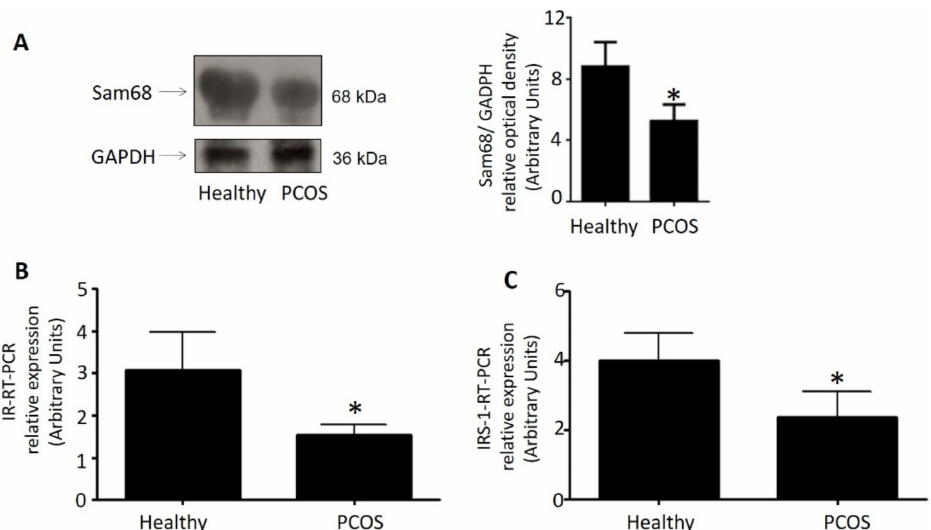
Figure 4. Diminished expression of Sam68, IR, and IRS-1 in GCs from PCOS women. GCs samples were obtained from 25 healthy donors and 25 PCOS women. ( A ) Representative Western blot analysis of Sam68 protein level in GCs from healthy donors and PCOS women. GC lysates were denatured and resolved by SDS-PAGE with anti-Sam68 antibodies, as described in Section 2. Loading controls were performed in the same membranes with anti-GAPDH. We show the corresponding densitometric analysis of three independent experiments as means ± SD. Statistical analyses were performed by ANOVA. ( B ) Relative mRNA level of IR in GCs from healthy donors and PCOS women, ( C ) Relative mRNA level of IRS-1 in GCs from healthy donors and PCOS women. Both IR and IRS-1 mRNA were quantified with qRT-PCR. RNA was extracted as described in Section 2. Cyclophylin was used as internal standard. Results shown are expressed as means ± SD from three independent experiments, run in triplicates; * p < 0.05 versus control. Statistical analyses were performed by ANOVA. Asterisks indicate significant differences from the control according to Bonferroni’s multiple comparison post-hoc